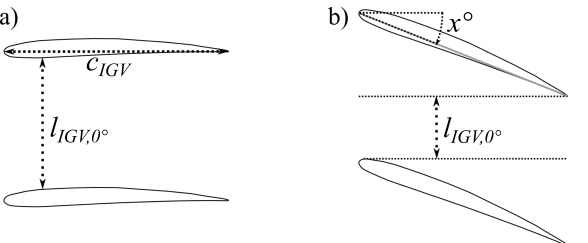
Figure 8. Variation of the passage width with respect to the IGV stagger angle: ( a ) stagger angle 0 ◦ and ( b ) stagger angle x ◦